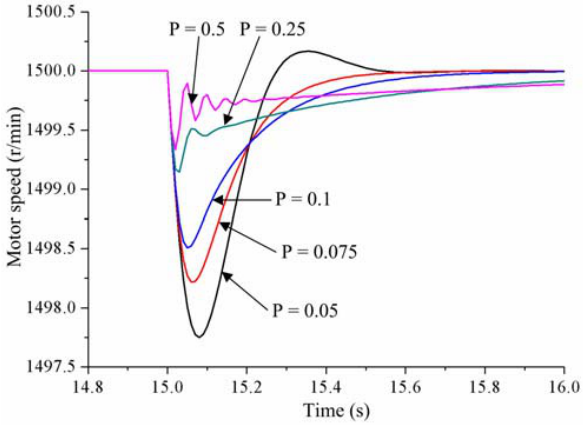
Figure 6. Simulated motor speed responses of the HESGS with different proportional gains.